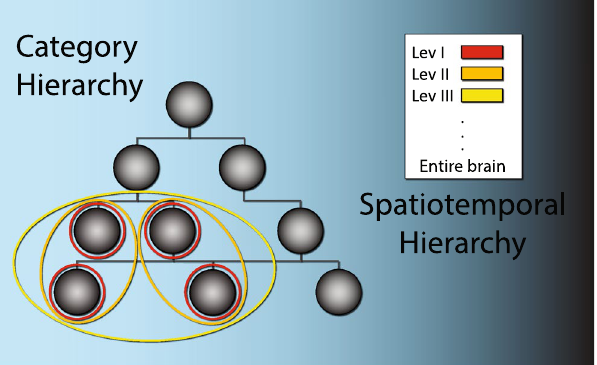
Figure 1. The importance of the hierarchical spatiotemporal structure of neural information processing. Each node in the tree (gray full circles) represents a category, starting from basic features, through objects and ultimately abstract concepts. For illustration purposes we assume each such node is processed by a single local network (red circles). Local networks processing related information need to be orchestrated into a higher order network (“binding”). This process must take place recursively up to the highest level of organization—the entire brain 39 . Because of synaptic delays, which depend on distance, as such higher order networks increase in scale spatially with order, length of communication cycle increases as well. Therefore, activity orchestrated to efficiently match this organization—a necessary precondition for effective information processing—will exhibit the right mixture of fast local events, and increasingly less frequent slower and more extended events. Conversely, the further activity is removed from optimal spatiotemporal makeup, information processing will degrade, until it all but vanishes. The latter can occur naturally, such as during dreamless sleep, as a result of pharmacologically active substances, e.g. anesthetics, or due to brain maladies, e.g. conditions leading to minimally conscious states.